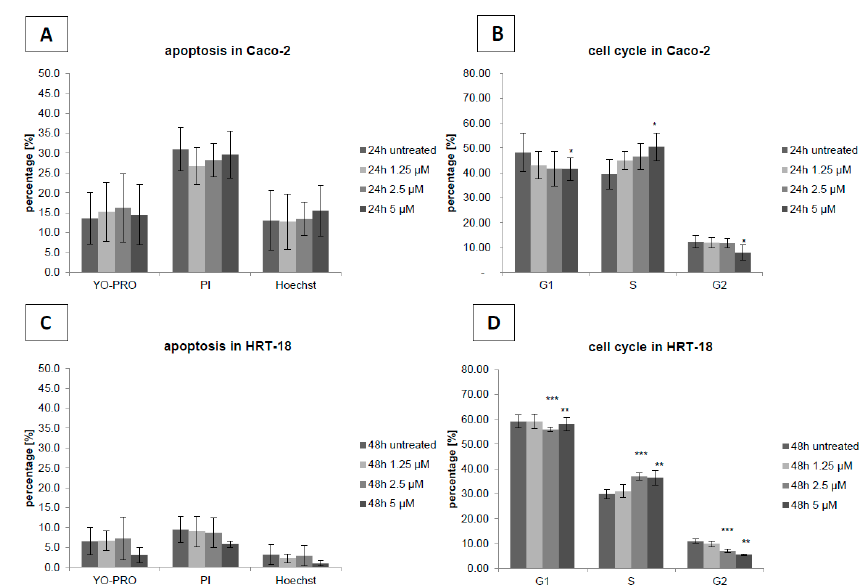
Figure 3. ( A , C ) No differences in staining patterns of YO-PRO, Hoechst and propidium iodide (PI) were observed after 24 h of sorafenib treatment in Caco-2 and after 48 h in HRT-18 cells and ( B , D ) A shift towards the S-phase in cell cycle was observed with increasing concentrations of sorafenib for both cell lines. *, **, *** indicate values significantly ( p < 0.05), highly significantly ( p < 0.01) or ( p < 0.001) different from the solvent control, respectively (two-sided, unpaired t -test); untreated DMSO control indicates untreated cell samples.